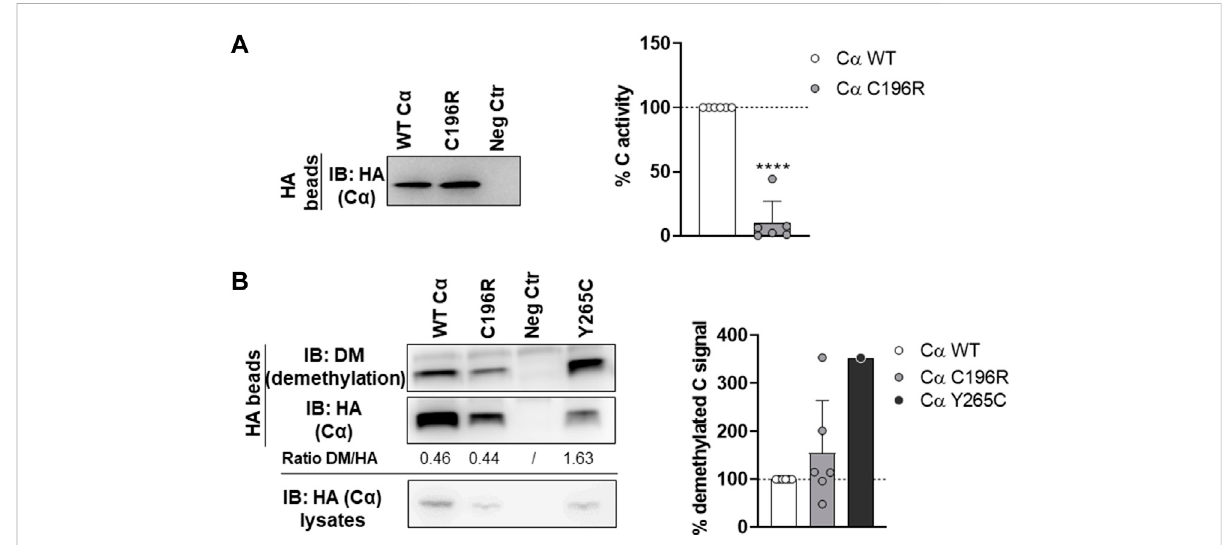
FIGURE 6 Phosphatase activity and carboxy-methylation of PP2A C α p.Cys196Arg. (A) Phosphatase activity of the PP2A C α p.Cys196Arg subunit. HA- taggedC α WTandp.Cys196ArgproteinswereisolatedfromtransfectedHEK293TcellsbyHA-pulldown.PP2AactivitywasmeasuredontheK-R-pT- I-R-R phospho-peptide using BIOMOL Green. Speci fi c PP2A activity was calculated via correction of the measured activities for the C α inputs (anti- HA immunoblotting). Left panel: immunoblot data from a representative experiment. As a negative control (Neg Ctr) pMB001 vector without insert (expressing only HA tag) was used. Right panel: graph representing the average speci fi c activity ±SD for the C α p.Cys196Arg variant in comparison to WT activity (set at 100% in each replicate, dotted line). An unpaired t test was used for statistical analysis ( n = 6; ****, p ≤ 0.001). (B) Carboxy-methylation status ofPP2A C α p.Cys196Arg. HA-tagged C α WT and p.Cys196Arg proteins werepuri fi edfrom transfectedHEK293T cells by HA-pulldown. PP2A C subunit methylation was assessed by immunoblotting with a demethyl-speci fi c anti-C monoclonal antibody. PP2A C α p.Tyr265Cys was used as a positive control for low carboxy-methylation status (hence, high demethyl) (Reynhout et al., 2019). Left panel: immunoblotfromarepresentativeexperiment.Asanegativecontrol(NegCtr)pMB001vectorwithoutinsert(expressingonlyHAtag)wasused.Right panel: graph displaying the average ratios of the quanti fi ed anti-demethyl signals over the quanti fi ed anti-HA signals ±SD in comparison to the demethylation levels of C α WT (set at 100% in each experiment, dotted line). An unpaired t test was used for statistical analysis ( n = 6, except p.Tyr265Cys: n =